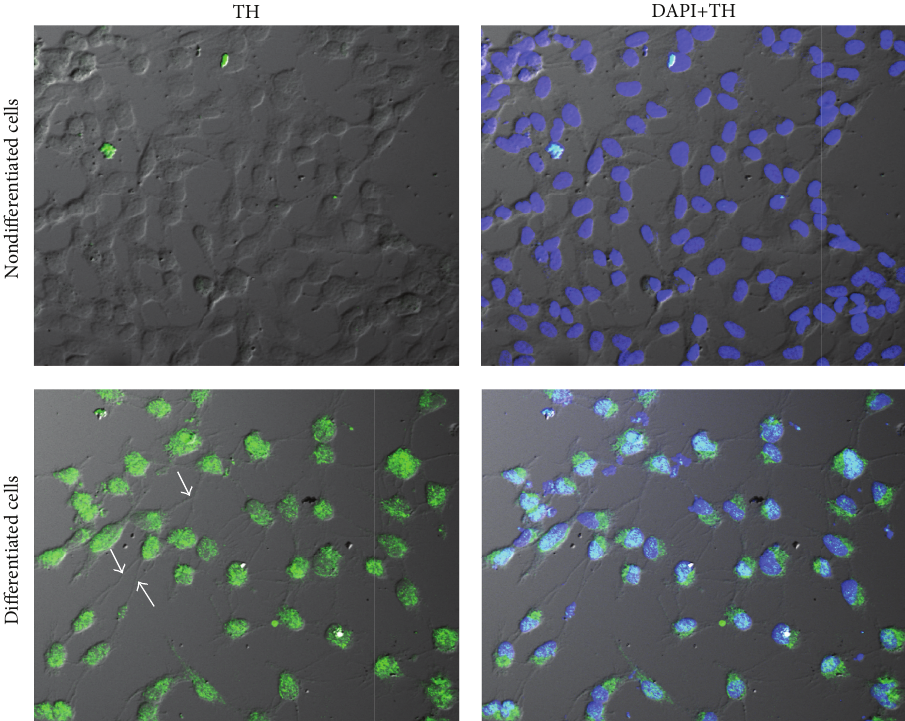
Figure 1: Expression of tyrosine hydroxylase in undifferentiated and differentiated SH-SY5Y cells. Cells were differentiated in 10 𝜇 M retinoic acid (RA). After differentiation for 3 days, expression of tyrosine hydroxylase (TH) was visualized through immunostaining in undifferentiated cells and RA-differentiated cells. Nuclei were stained using DAPI. White arrows indicate areas of neurite outgrowth.